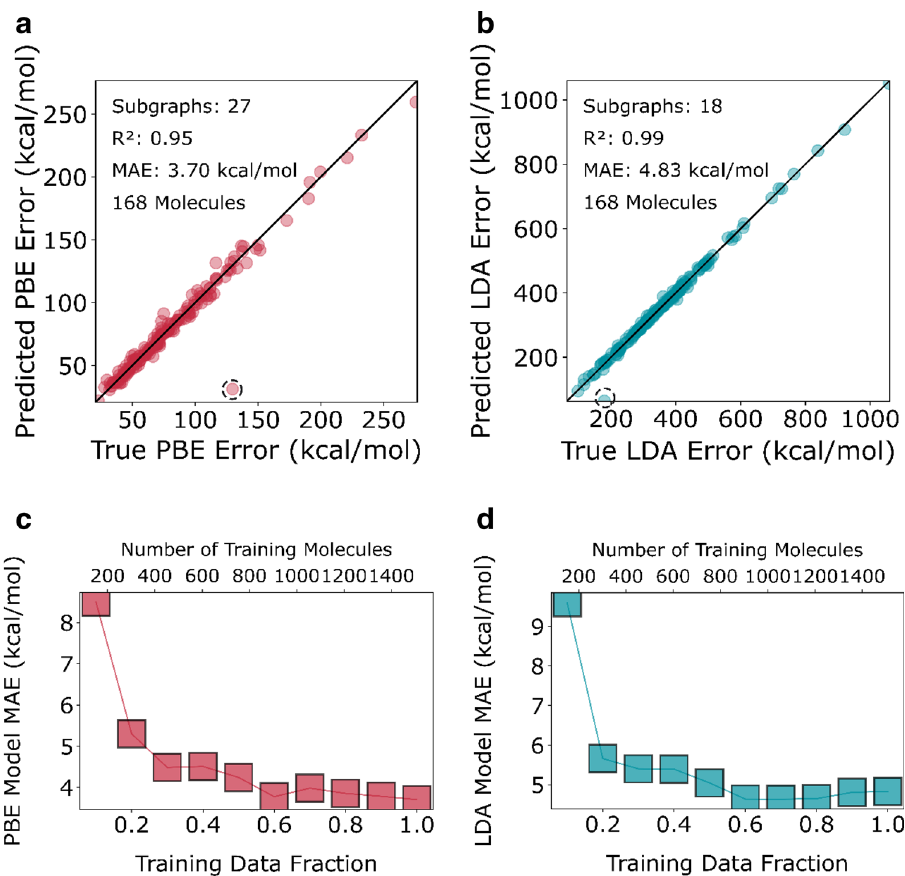
Figure 2. Parity plot of error formation enthalpy predicted by surrogate LASSO model on the test set versus the true error in enthalpy calculated using the PBE functional. The outlier circled is phosphorus dioxide (129.7, 31.25). ( b ) Error in enthalpy calculated using the LDA functional. The circled outlier is again phosphorus dioxide (179.6, 64.47). Learning curves for the ( c ) PBE and ( d ) LDA models. The boxes represent mean absolute error on the externally held out test set on models trained on the respective fractions of the training